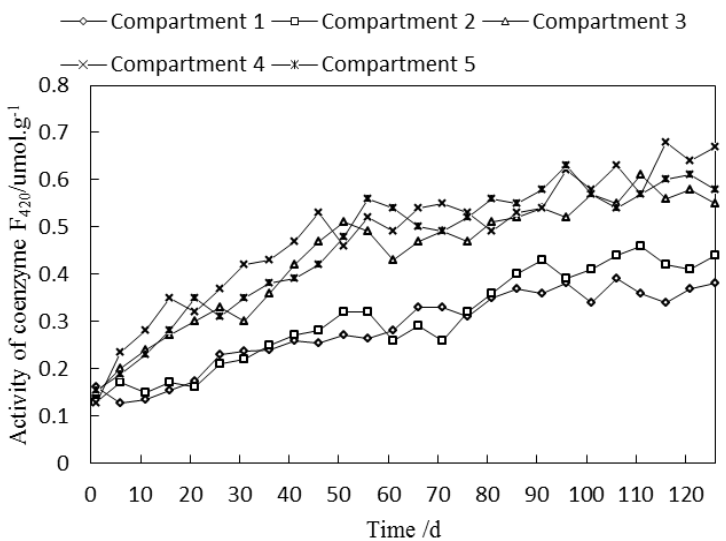
activity in the 420